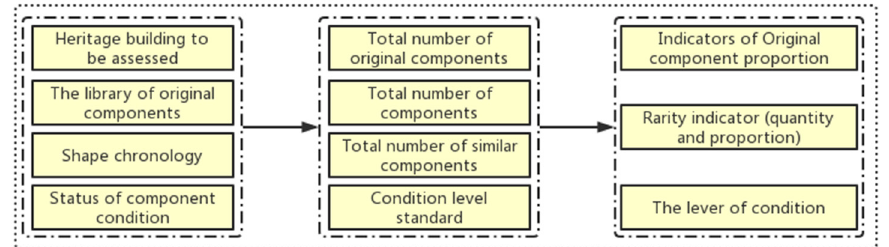
Figure 10. Reference indicators for heritage evaluation.